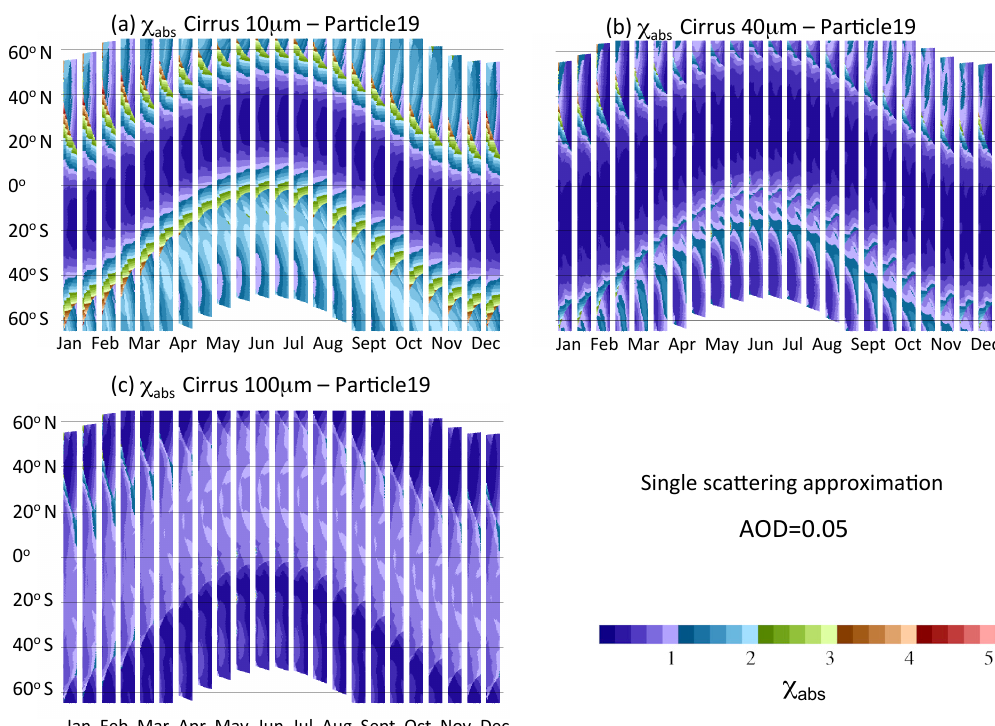
Fig. 15. Same as Fig. 14 but comparing MISR Particle 19 with three cirrus particles: (a) D e = 10µm, (b) D e = 40µm, and (c) D e =